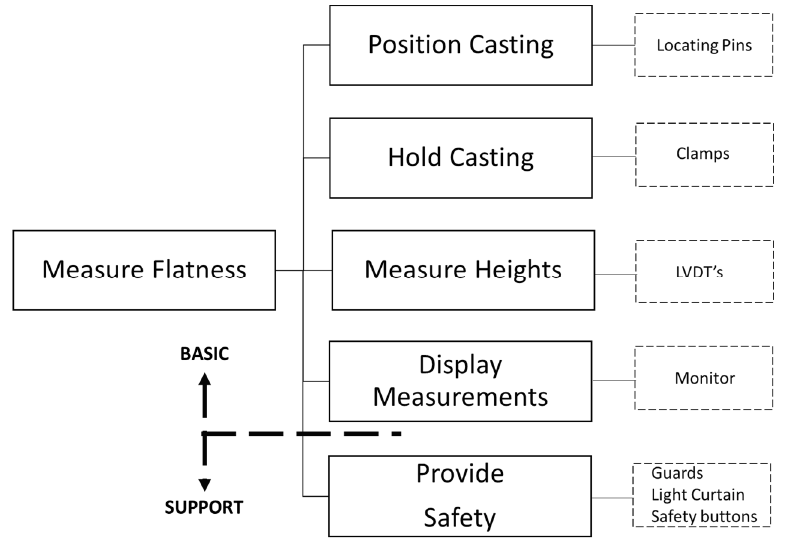
Figure 8. Simplified function analysis tree of the current measuring station. Physical components are shown in dashed boxes.